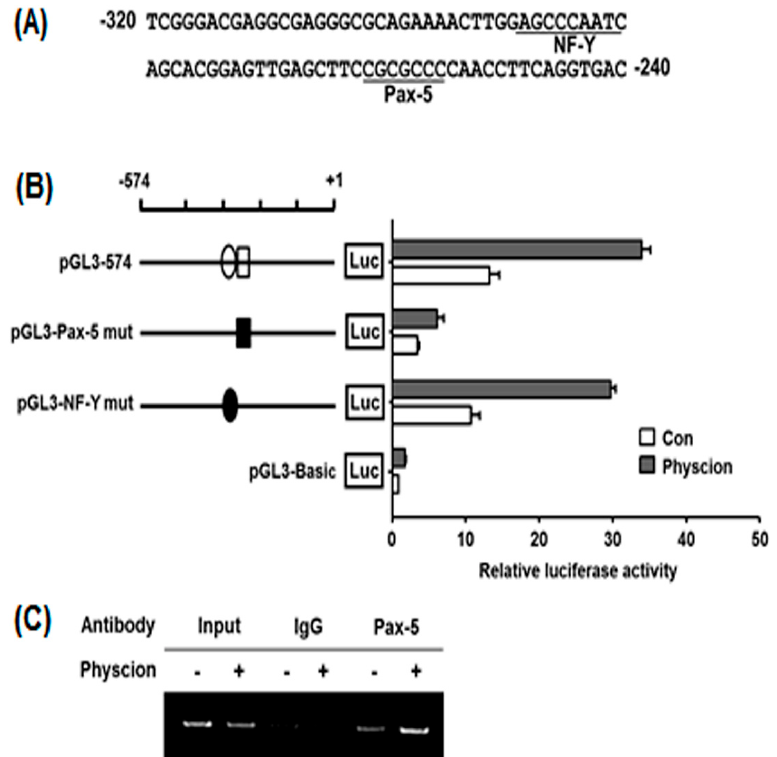
Figure 5. Promoter mutation assay for the transcription factor-binding sites in the nucleotide − 320 to − 240 region of the hST8Sia VI gene in physcion-induced SK-N-BE(2)-C cells. ( A ) Nucleotide sequences of the promoter region from − 320 to − 240 are shown; ( B ) After co-transfection of each construct into SK-N-BE(2)-C cells with pRL-TK, relative firefly luciferase activity was assessed. The Renilla luciferase activity derived from pRL-TK was used to normalize all firefly luciferase activity. Data are the means ± SD of triplicate measurements and are representative of three independent experiments. The circle and square indicate NF-Y and Pax-5 binding sites, respectively. The white and black colors indicate wild-type and mutant forms of these sites, respectively; ( C ) ChIP assay was conducted with primers amplifying the − 379 and − 131 region of the hST8Sia VI promoter and DNA isolated from chromatin immunoprecipitated with either anti-Pax-5 antibody or control IgG from SK-N-BE(2)-C cells treated for 24 h with or without 40 μ M physcion.